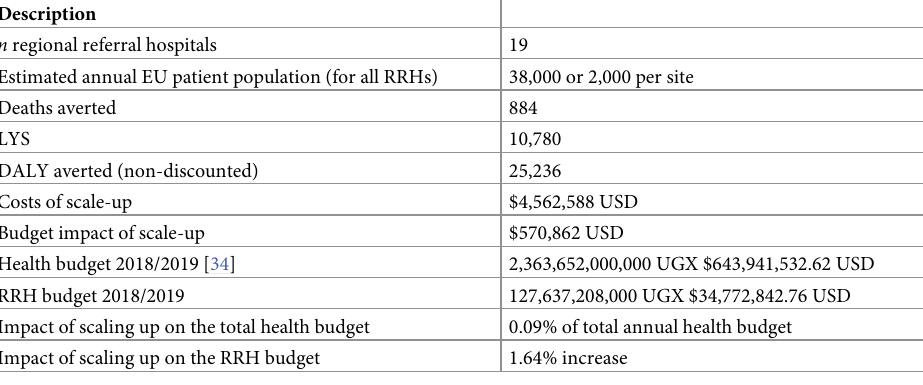
Table 4. Budget impact analysis cost of national scale up to all RRHs.